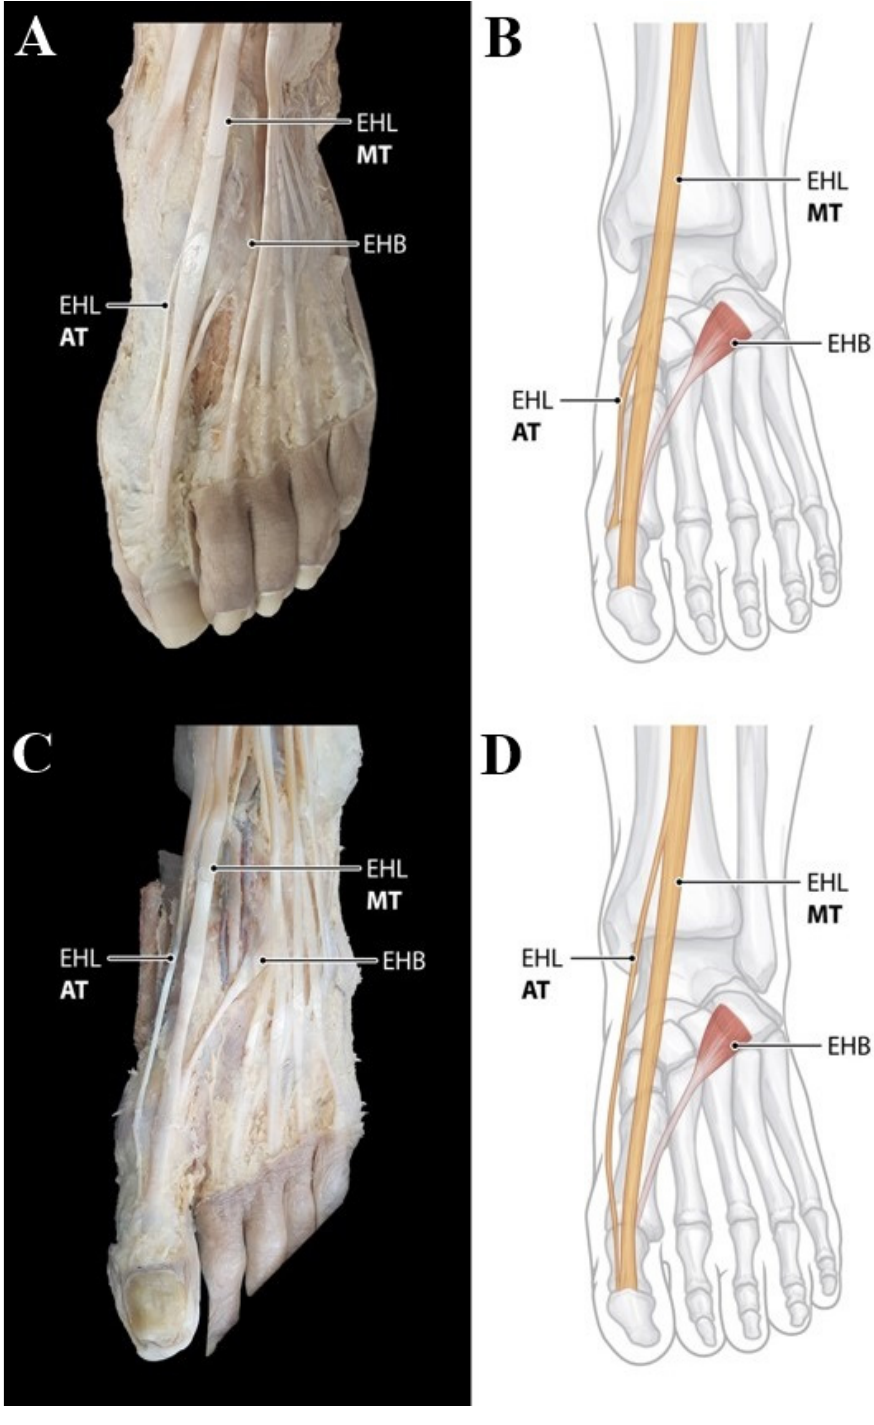
Figure 3. Type 2 EHL tendon variation. ( A ) Photo of Subtype 2A. The medial accessory tendon inserts to the dorsal aspect of the proximal phalanx base of the hallux. ( B ) Schematic drawing of Subtype 2A. ( C ) Photo of Subtype 2K. The medial accessory tendon inserts onto the first interphalangeal joint capsule. ( D ) Schematic drawing of Subtype 2K. AT, accessory tendon; EHB, extensor hallucis brevis tendon; EHL, extensor hallucis longus tendon; MT, main tendon.